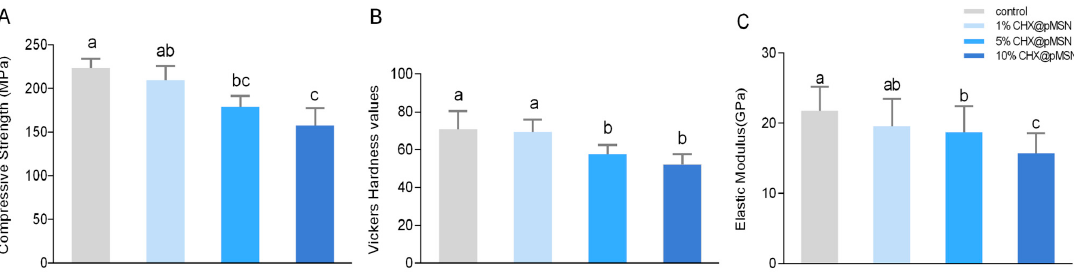
Figure 5. Mechanical properties of control, 1%, 5%, and 10% CHX@pMSN groups. ( A ) Compressive strength; ( B ) Vickers hardness; and ( C ) elastic modulus. Data are shown as mean ± standard deviation. The groups labeled with the same letters have no significant difference ( p > 0.05).